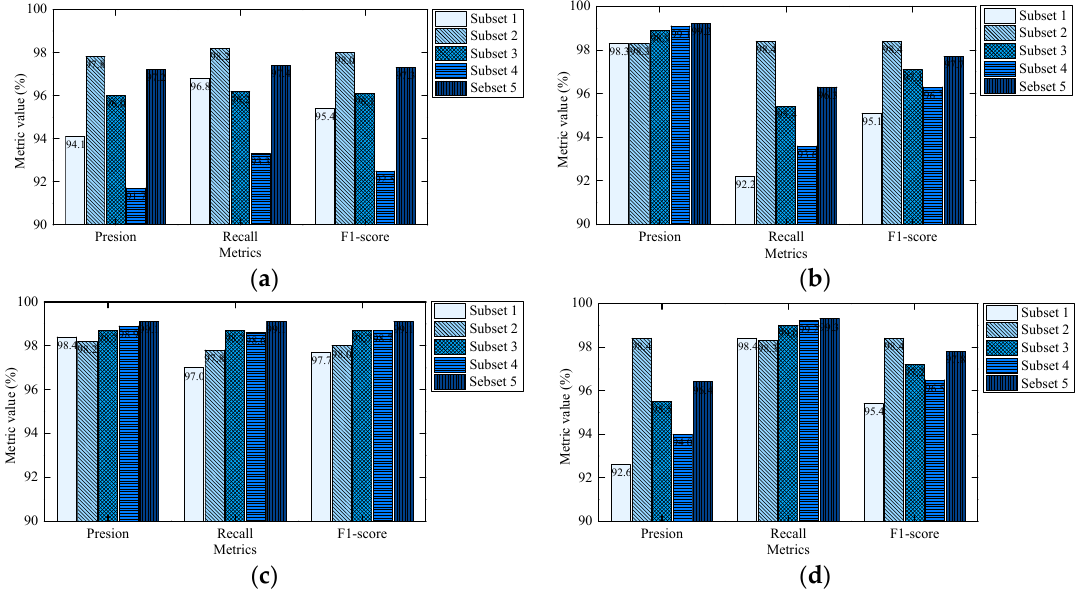
Figure 11. Model performance evaluation using different datasets. ( a ) Arching detection performance on the validation set; ( b ) Arching detection performance on the testing set; ( c ) Normal detection performance on the validation set; ( d ) Normal detection performance on the testing set.